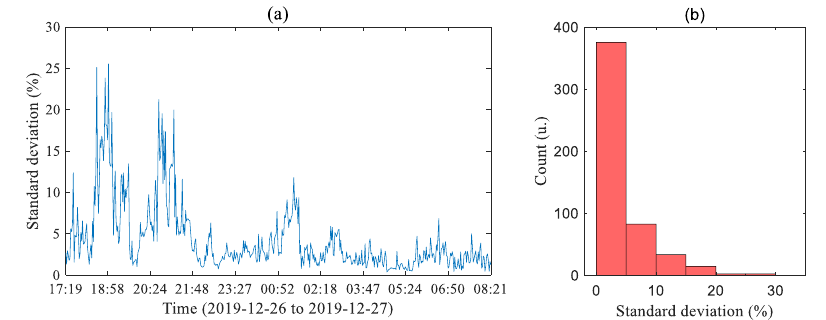
Figure 10. ( a ) The standard deviation between the SLidar curve and the pulsed lidar curve in the region of 1050–1500 m, and ( b ) statistical distribution of the standard deviation. The lidar curve measured by the SLidar system has been multiplied with the system constant before the evaluation.